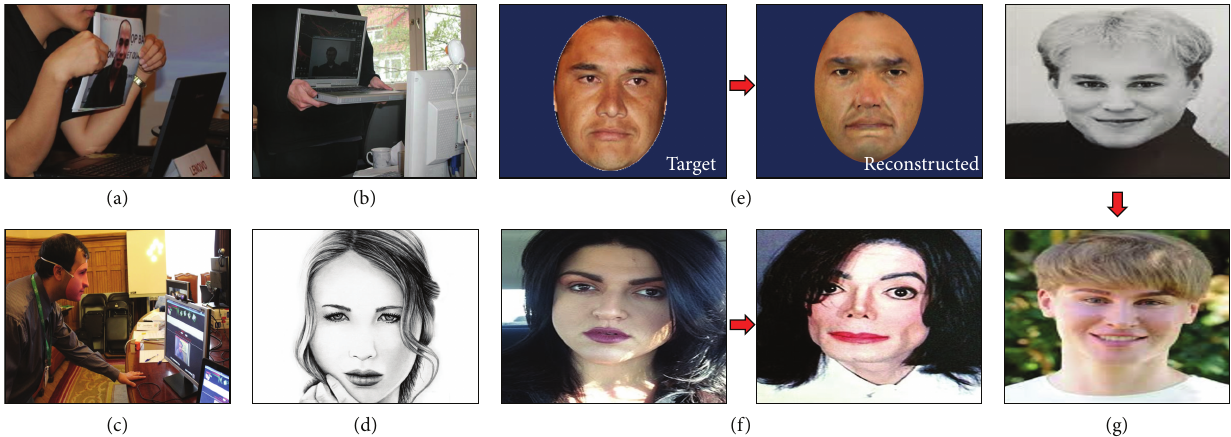
Figure 2: Examples of face spoofing using (a) photograph, (b) video, (c) 3D mask, (d) sketch, (e) reverse-engineered face image, (f) make-up (skillful application of make-up to look like Michel Jackson), and (g) plastic surgery (this boy underwent excessive plastic surgery to look like Justin